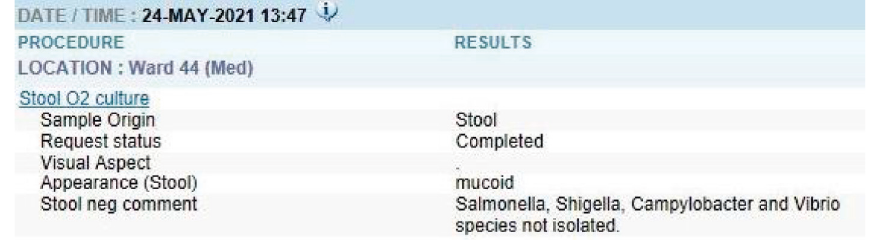
Figure 3: Stool culture report after 3-day course of